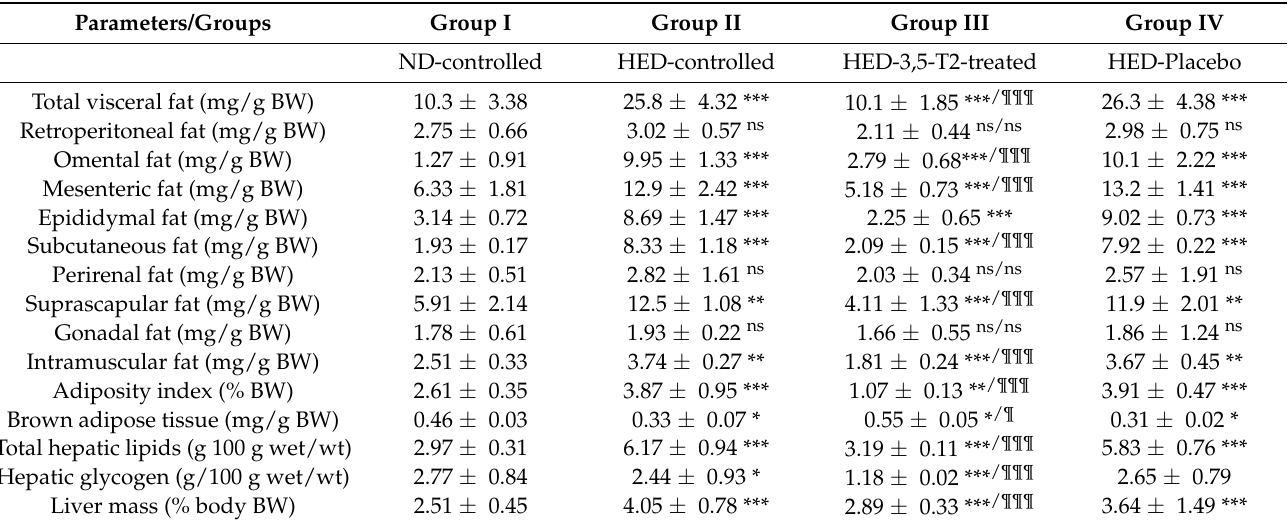
Table 3. In vivo effects of 3,5-T2 on body adipose tissue repartition and hepatic metabolic biomarkers from experimental P. obesus